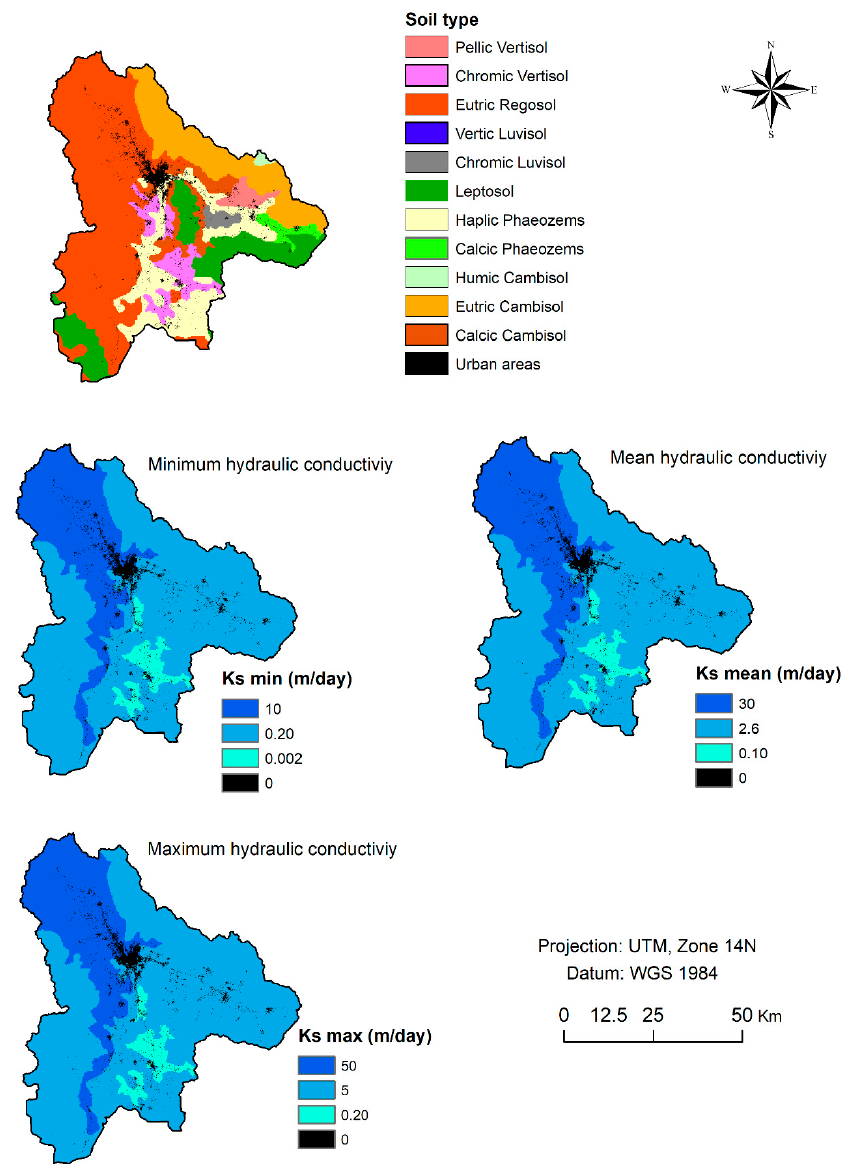
Figure 2. Soil type and hydraulic conductivity distribution